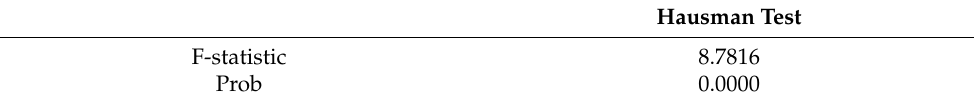
Table 5. Hausman test results.